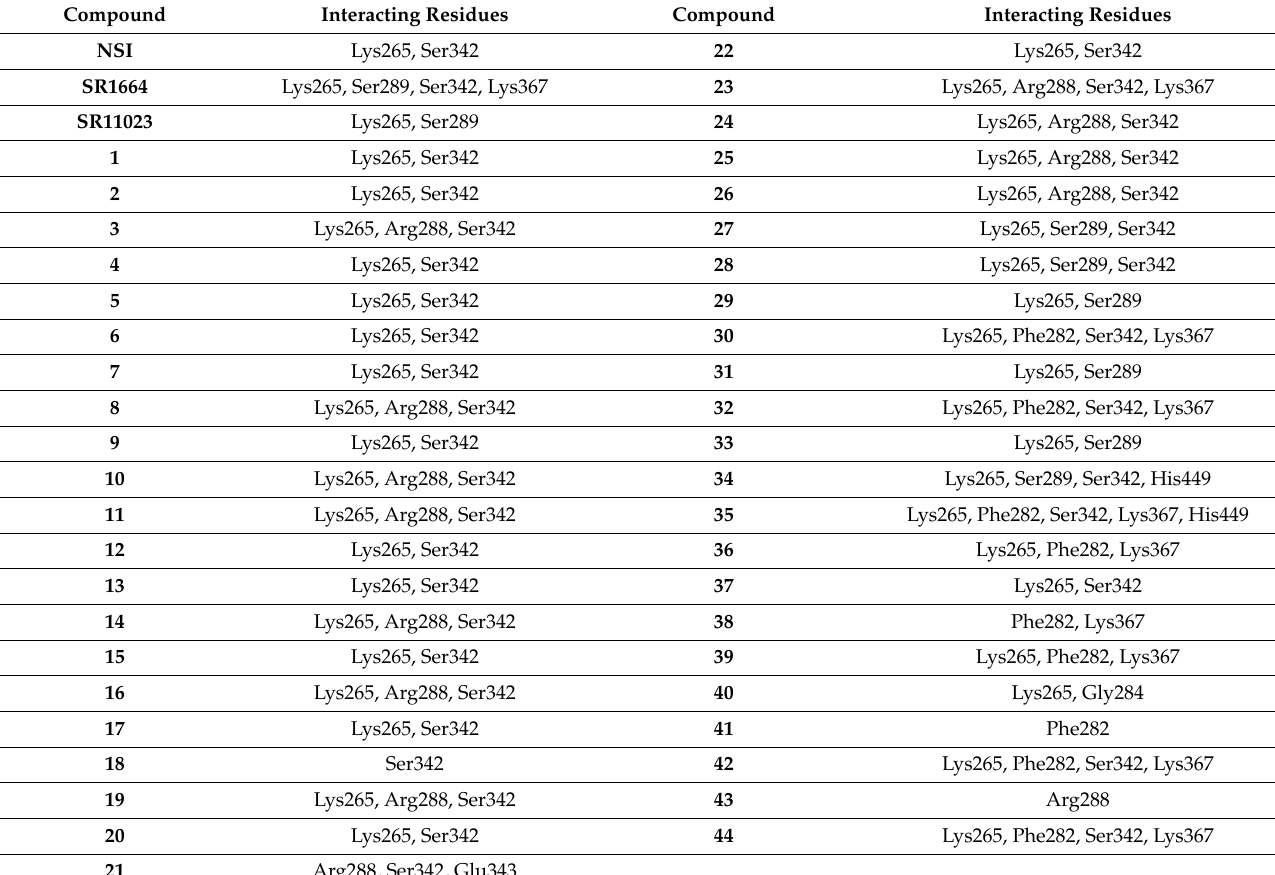
Table 4. Interacting residues of PPAR γ antagonists at the allosteric